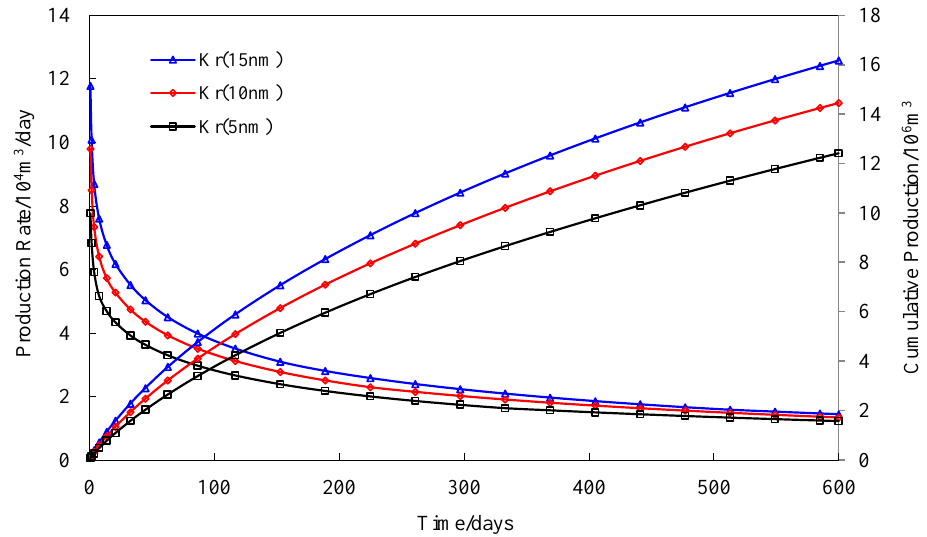
Figure 16. Effect of relative permeability on gas production rate and cumulative production (decline curves represent gas production rate curves, increasing curves represent cumulative production curves).